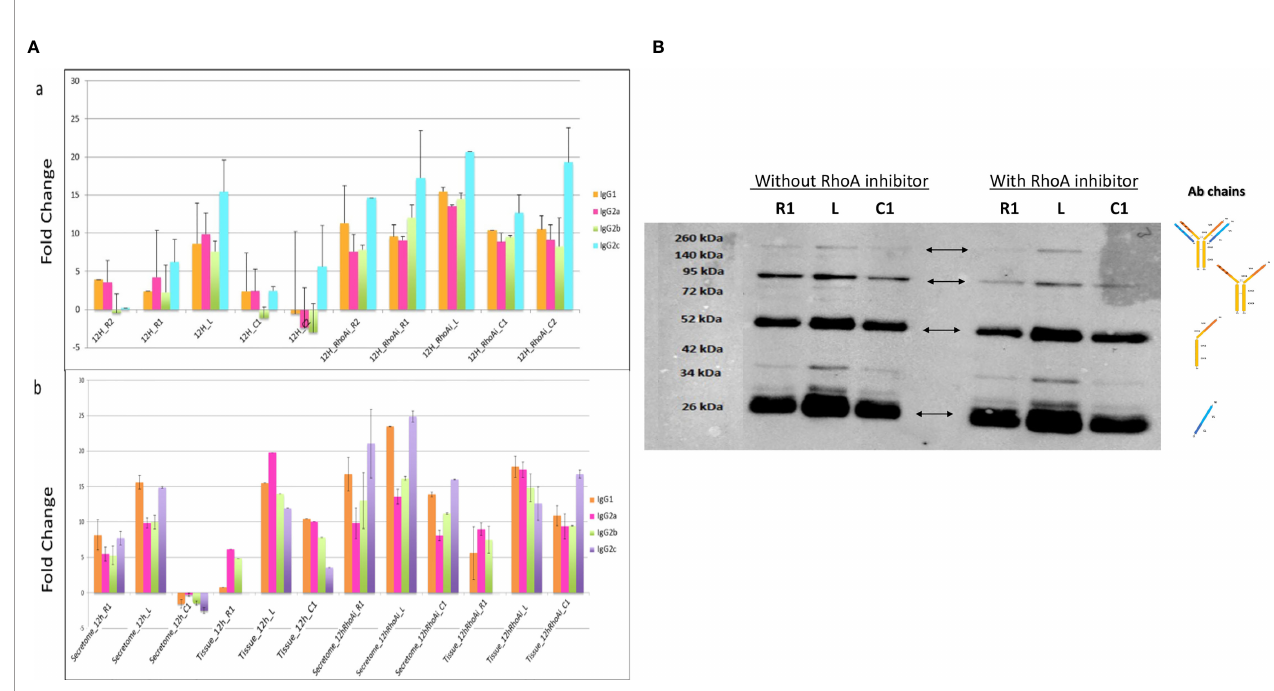
FIGURE 4 | (A) (a) Fold change between IgG isotypes in secretome from the different segments collected 12 h after SCI and treatment with RhoA inhibitor. (b) Fold change of IgG isotypes between tissue and secretome. (B) Detection by Western blot of IgG chains in secretomes from rostral, caudal, and lesion segments collected 12 h after lesion and treatment with RhoA